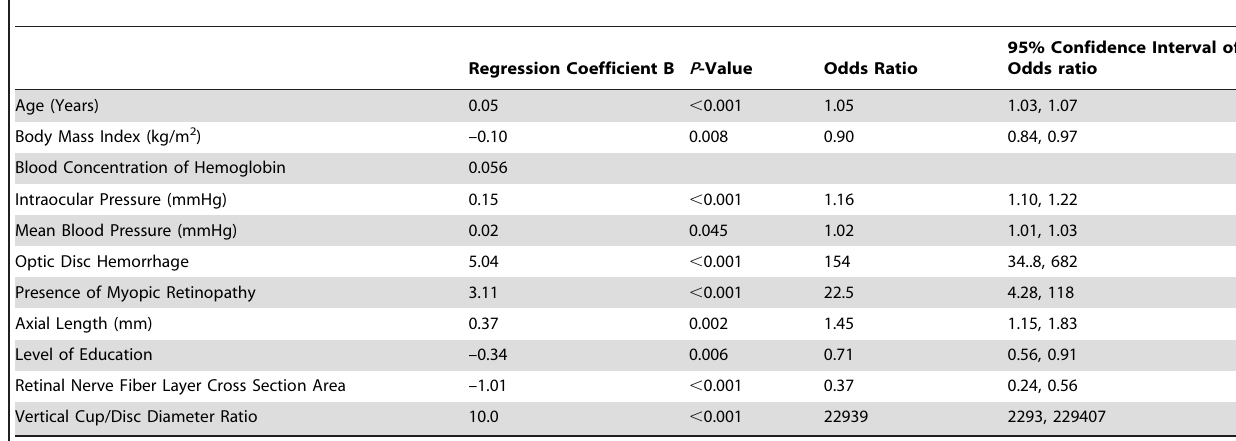
Table 2. Associations between the Prevalence of Open-Angle Glaucoma and Systemic and Ocular Parameters (Multivariable Analysis) in the Central India Eye and Medical Study.